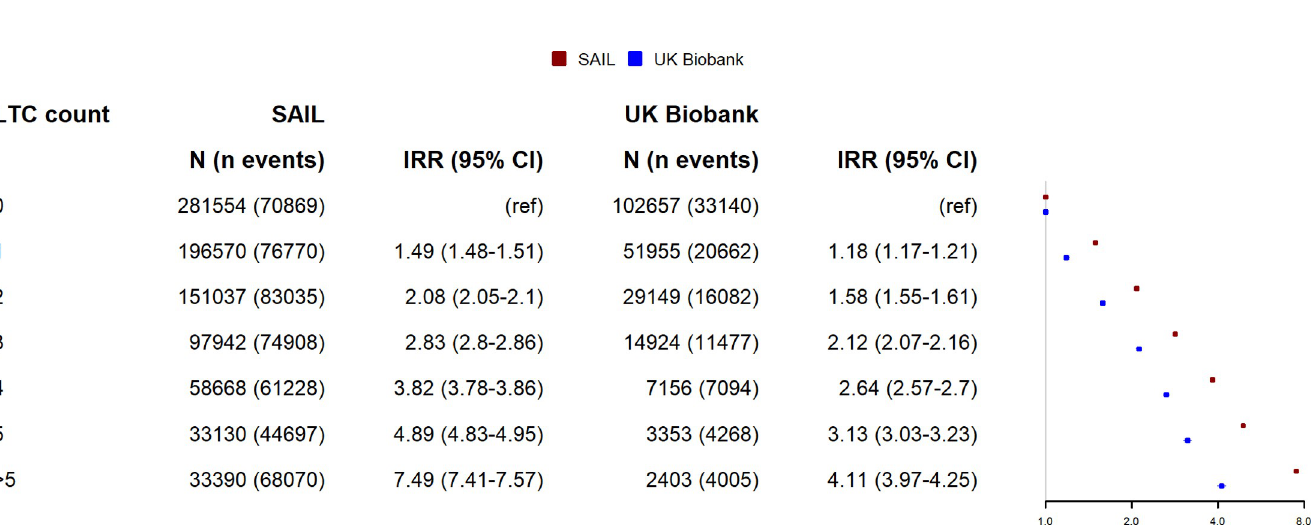
PLOS Medicine| https://doi.org/10.1371/journal.pmed.1003931 March 7, 2022 13 /